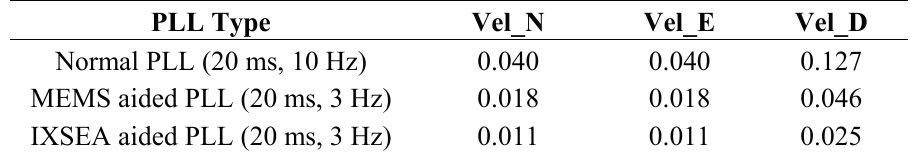
Table 4. Standard deviations of velocity errors (in m/s) of integrated